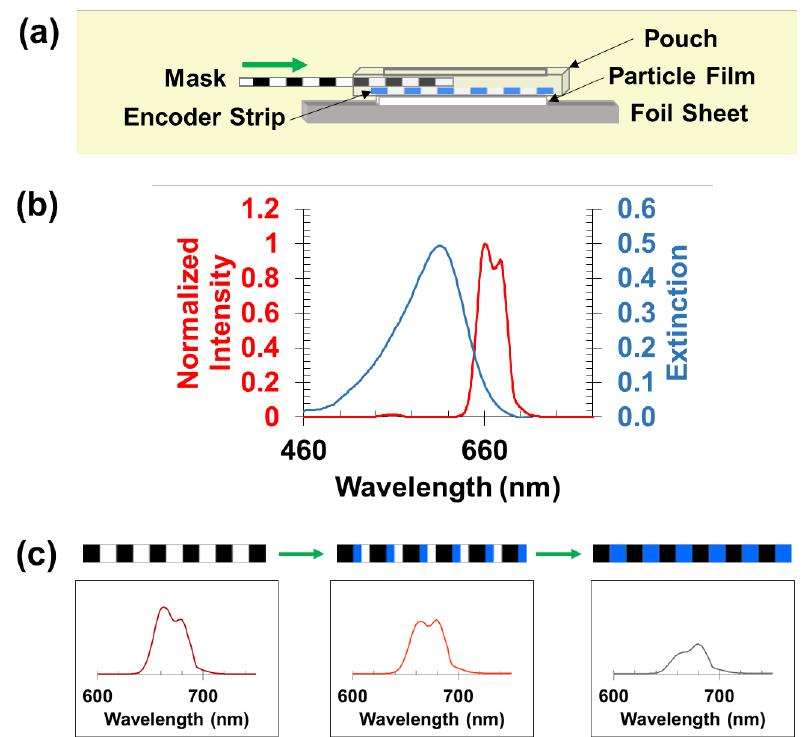
Figure 3. ( a ) Schematic of the spectral ruler sensor design showing assembly of the sensor inside a semi-rigid laminating pouch. The sensor assembly overlays an upconversion microparticle film. ( b ) Absorbance spectrum of bromocresol green (pH 8) in solution overlaid upon the emission spectrum of a Gd 2 O 2 S:Yb,Er film excited with 980 nm light. ( c ) Three distinct positions of the encoder with respect to the analyzer mask are shown with their corresponding emission spectra. As the analyzer windows move and reveal a larger fraction of dye-covered phosphors, the less low wavelength emission is detected compared to higher wavelength